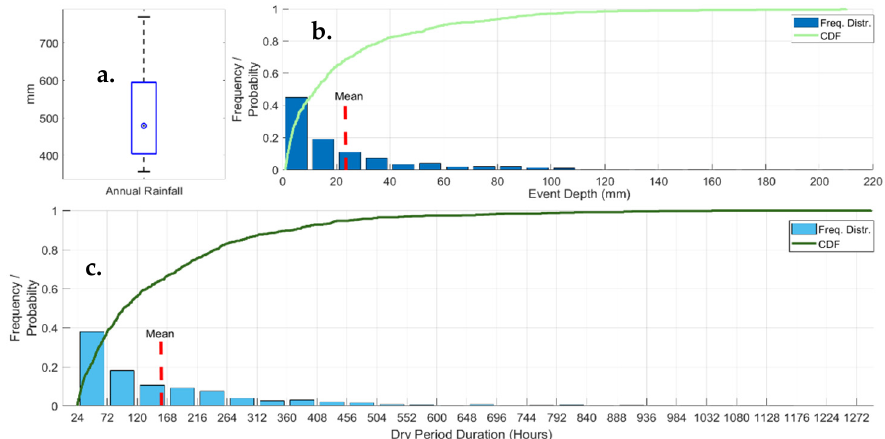
Figure 2. Rainfall data from Bet Dagan (Israel) meteorological station ( a ) Box plot of annual rainfall. ( b ) Frequency distribution and empirical cumulative distribution function (CDF) of rain events depth. ( c ) Frequency distribution and empirical CDF of dry periods (within the rainy season).